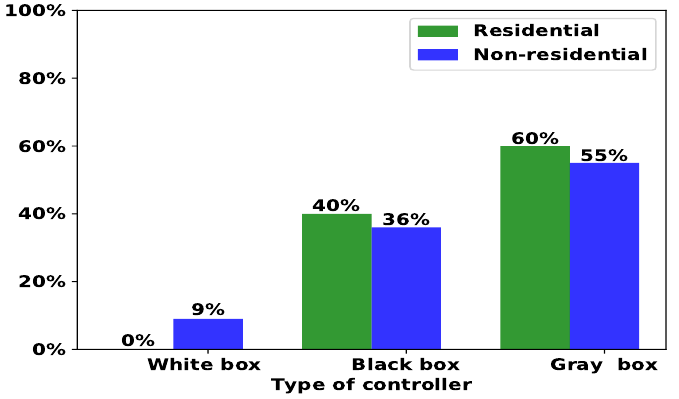
Figure 12. Controller used for demand response application in non-residential and residential